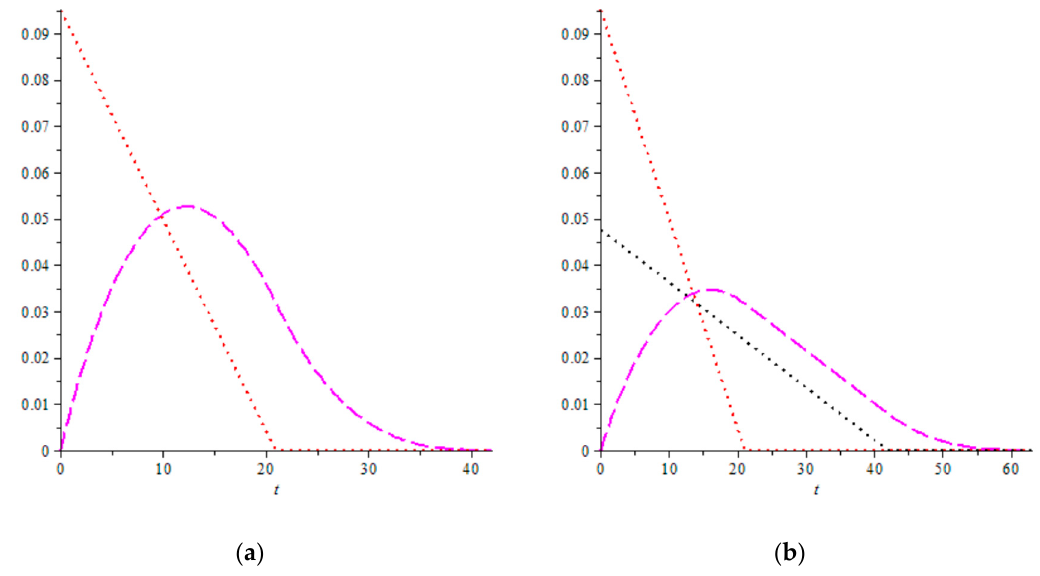
Figure 10. PDFs for travel times of a random trip (pink dash) in taxicab geometry and its parts—the random trip in direction X (black dot) and direction Y (red dot): ( a ) in a square-in-time zone with T x = T y = 21 s ; ( b ) in a zone with T x = 2 T y = 42 s .